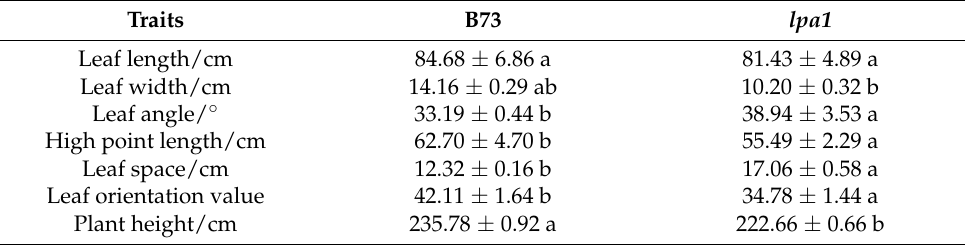
Figure 3. Analysis of index of wild-type and mutant lpa1 . ( A ) Leaf angle with the greatest difference; ( B ) leaf angle of 2–10 leaves in trumpet stage. * indicates p < 0.05. Table 1. Analysis of relevant characters of wild-type B73 and mutant lpa1 cloverleaf.